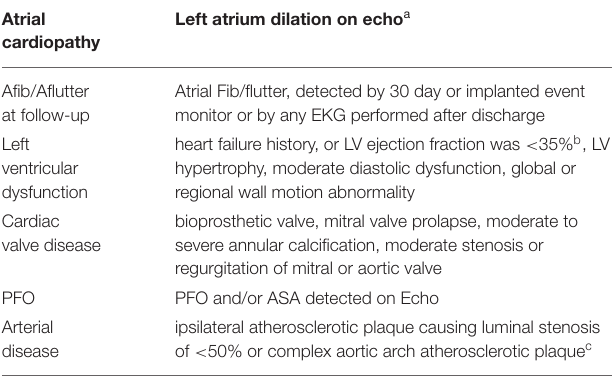
TABLE 1 | Definition of potential embolic sources